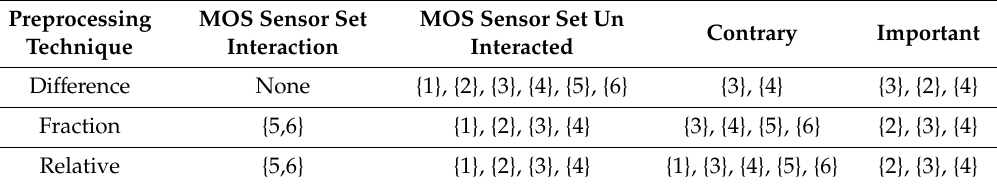
Table 1. Summary of the performance of the classifier for data sensors sets.